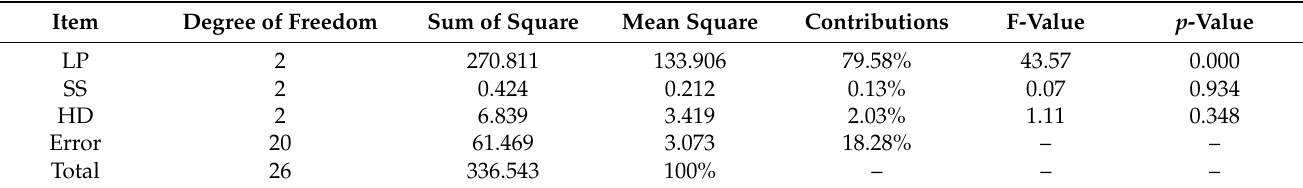
Figure 7. Contour plot showing the influence of process parameters on the RD of as-built W.